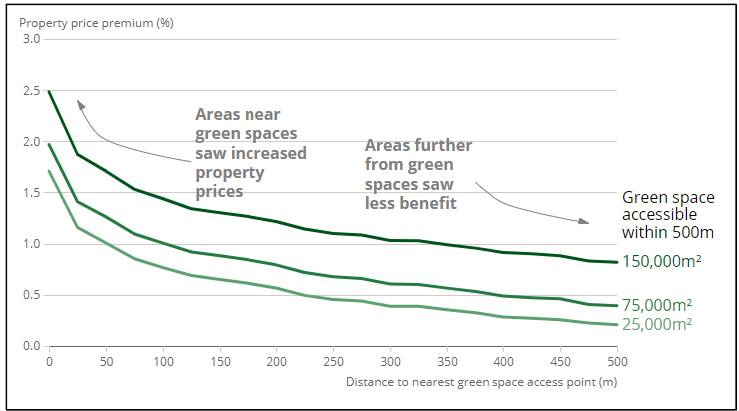
Figure 8. Percentage increase in the price of properties in accordance with their closeness to green spaces depending on the size of the green area and their distance from it [10] .